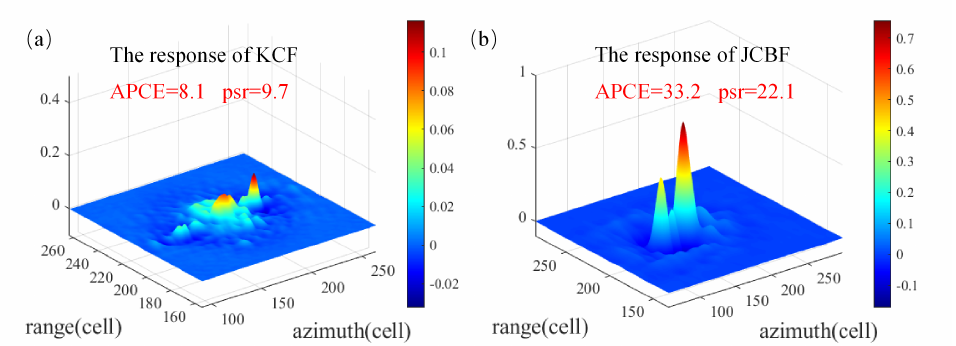
Figure 8. The response maps of ( a ) KCF and ( b ) JCBF (target 1 in frame